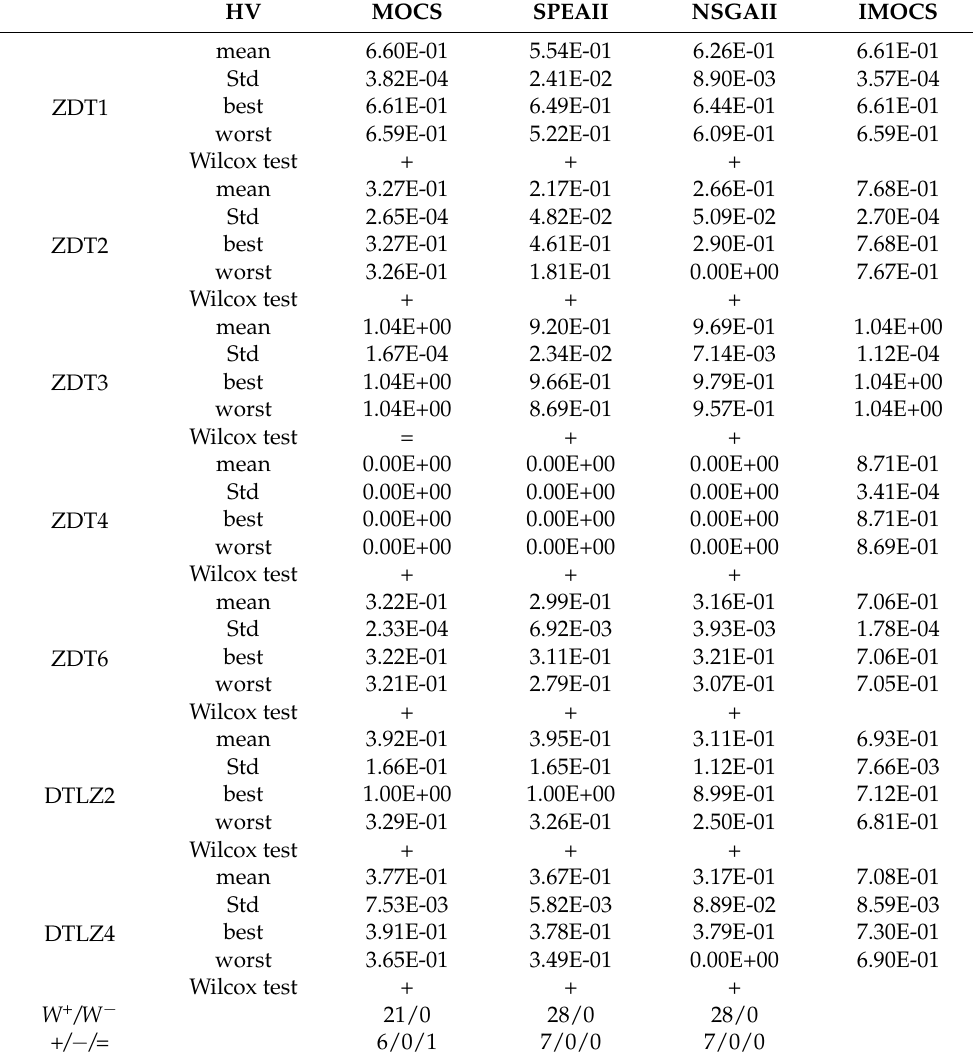
Table 5. Related statistical data based on the